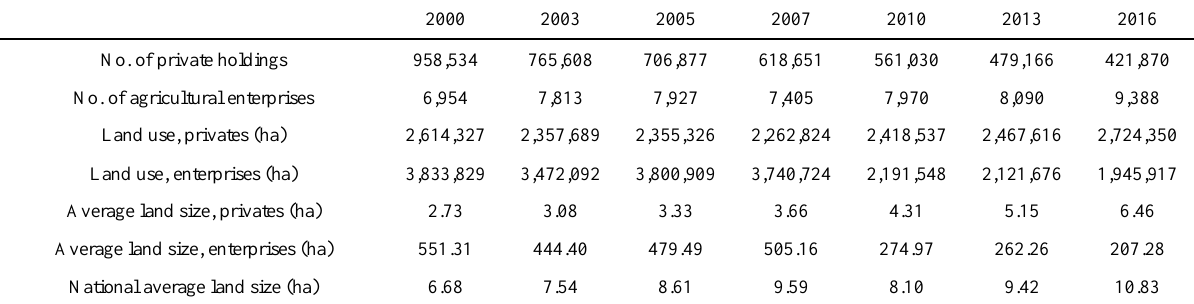
Table 2. Number and size of agricultural units, 2000-2016* [19]